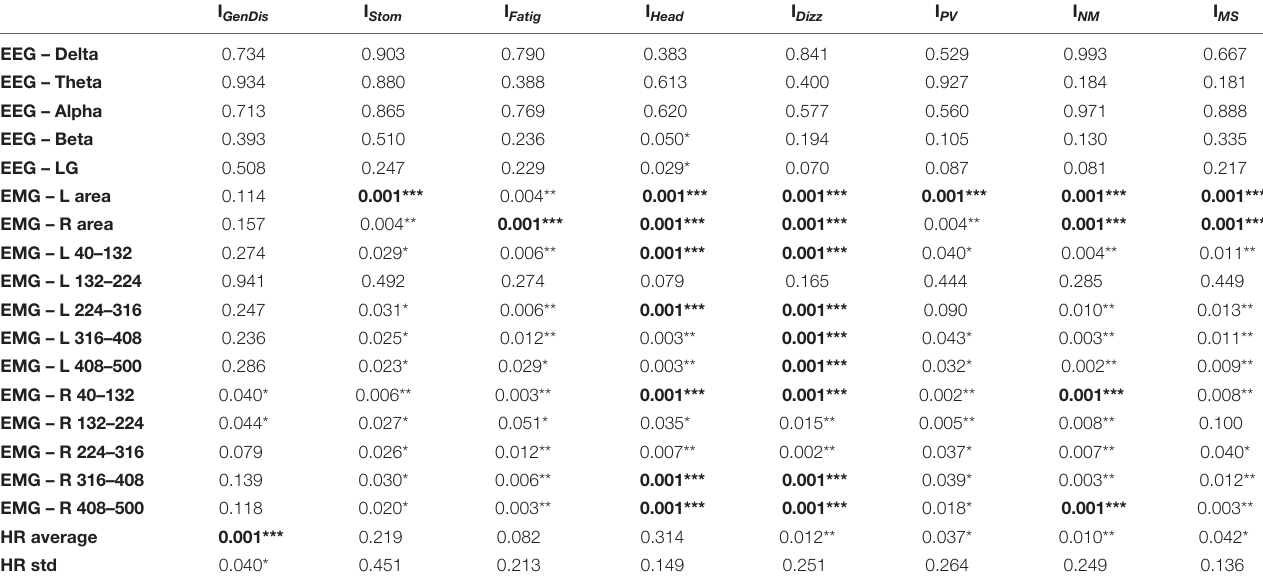
TABLE 5 | Significance of the 19 biometric parameters calculated with the univariate statistical analysis (Mann–Whitney test) for all the eight